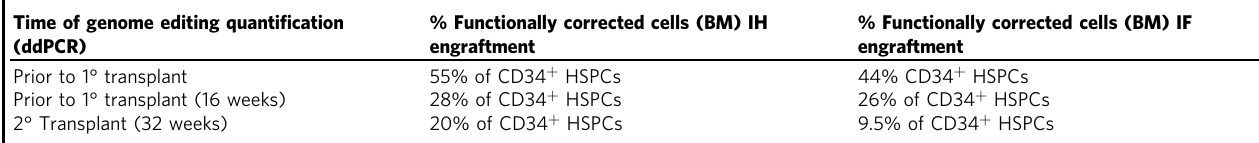
% Functionally corrected cells (BM) IH engraftment